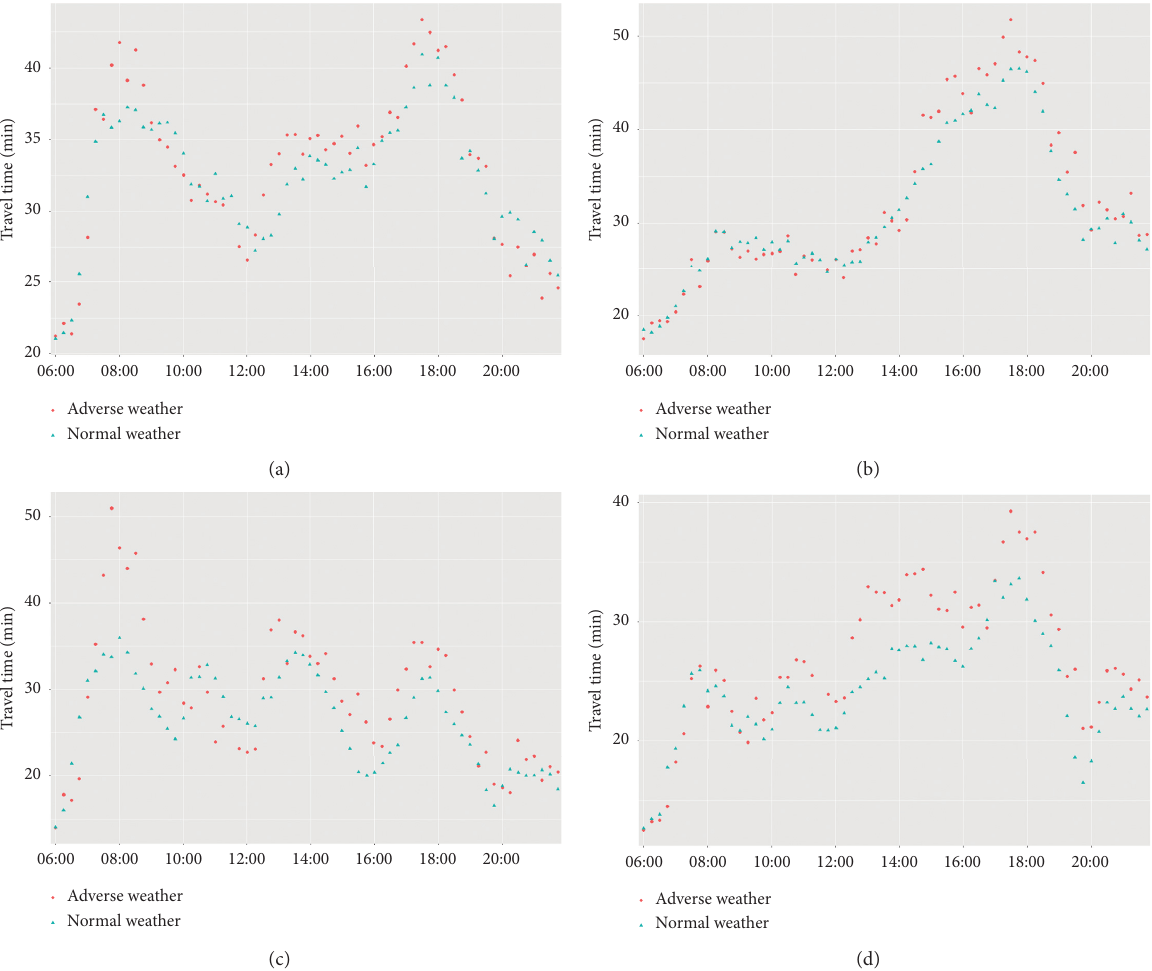
Figure 2: Travel time of each route under different weather conditions. (a) Yanan arterial road Eastbound. (b) Yanan arterial road Westbound. (c) Yanan elevated expressway Eastbound and (d) Yanan elevated expressway